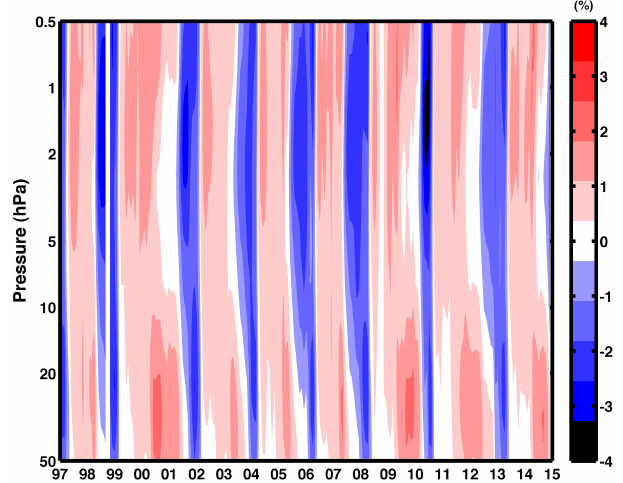
Figure 7. Amplitude of the ozone-QBO determined by multilinear regression for the time interval from January 1997 to January